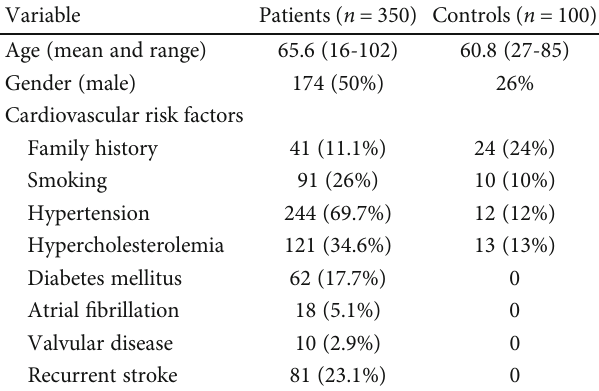
Table 1: Demographic and clinical information of patients and controls.